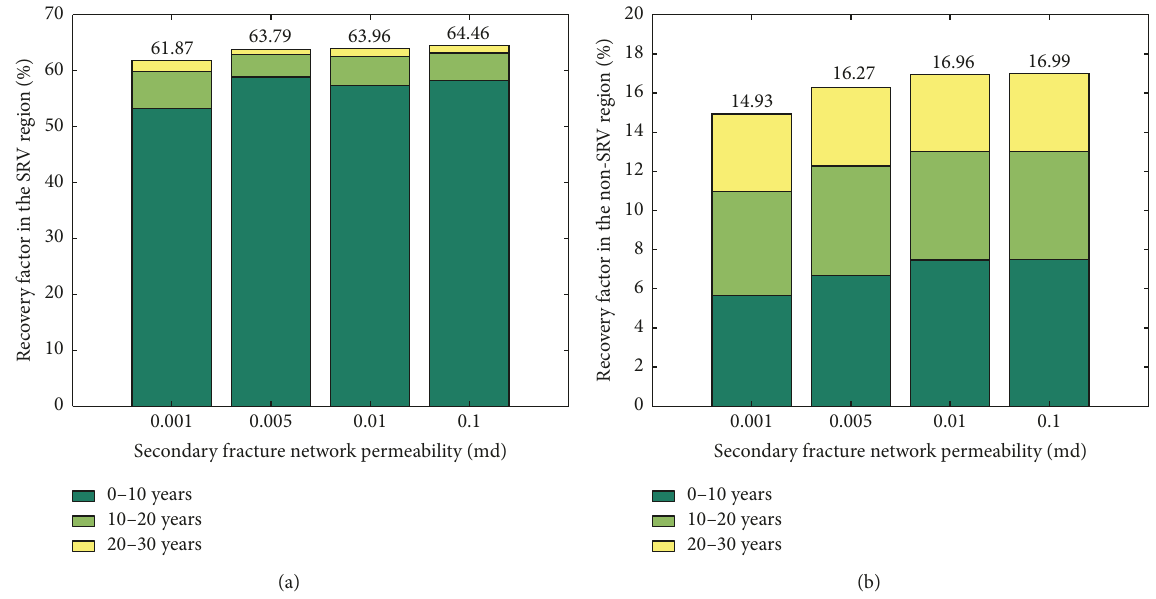
Figure 9: The effect of secondary fracture network permeability on the recovery factor: (a) SRV region; (b) non-SRV region.